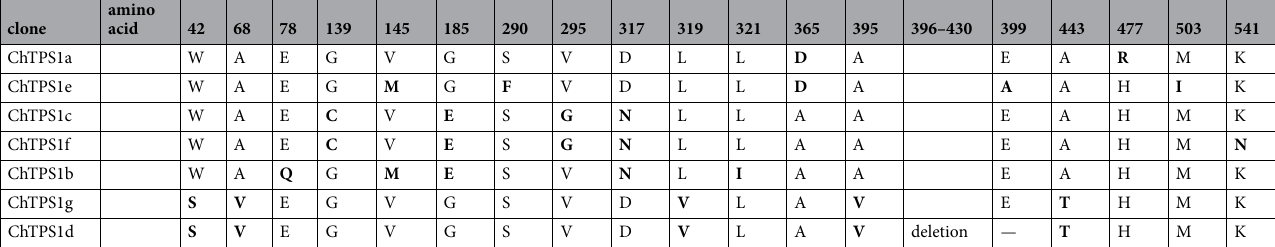
Table 1. Amino acid substitutions and a deletion observed in the 7 ChTPS1 clones. Substituted (or minor) amino acids are highlighted in bold. Amino acids from 396 to 430 were deleted in clone d. The order of the clones was rearranged depending on their substitution similarity.